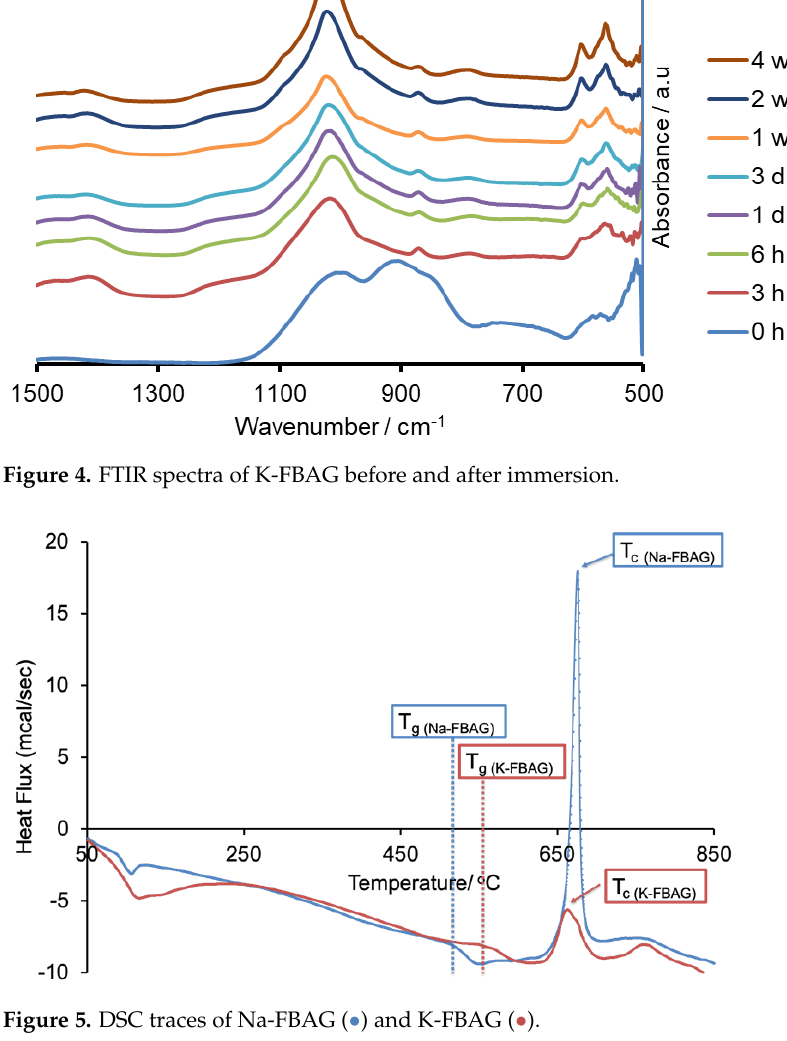
Figure 5. DSC traces of Na-FBAG ( • ) and K-FBAG ( • ).